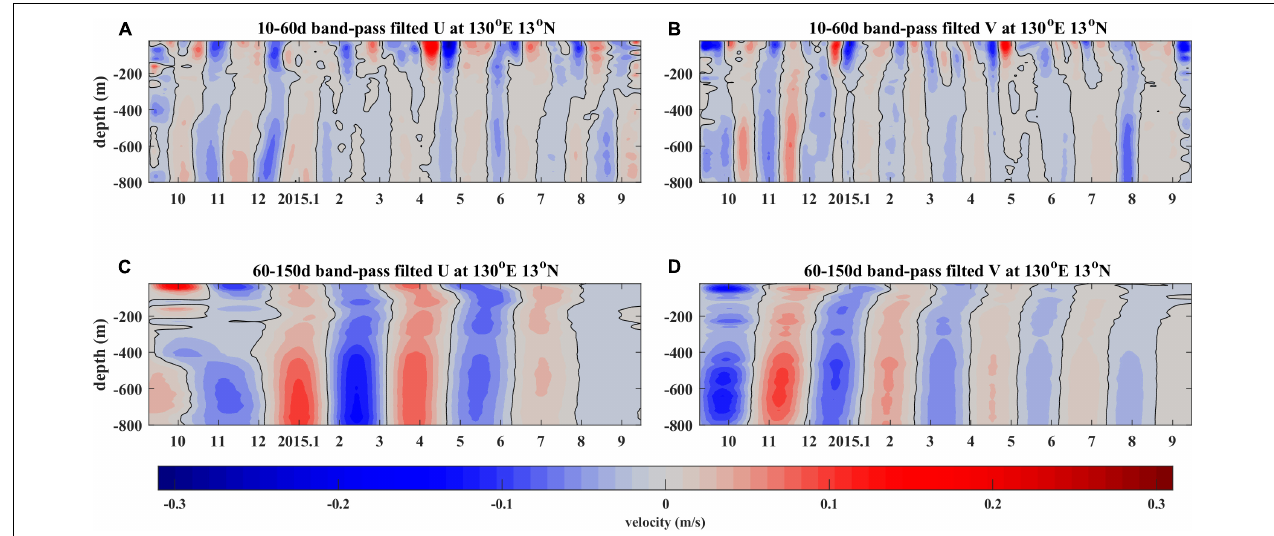
FIGURE 4 | Daily mean zonal (A) and meridional (B) velocity anomalies after a 10–60 days band-pass filtering. (C,D) are the same as the upper panel, but for 60–150 days band-pass filtering.